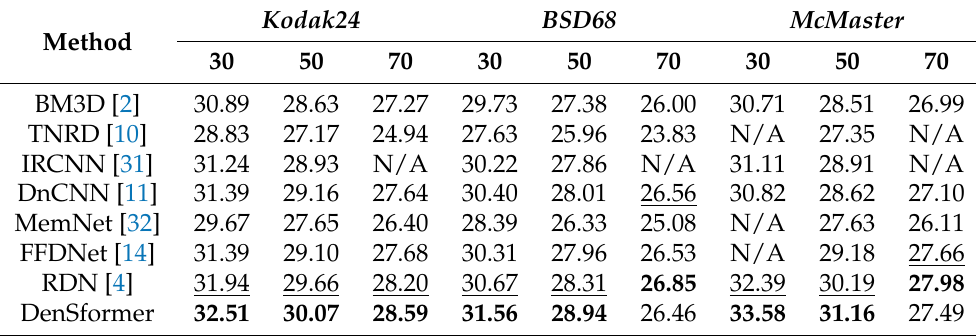
Table 2. Quantitative results about non-blind color image denoising (PSNR (dB)).